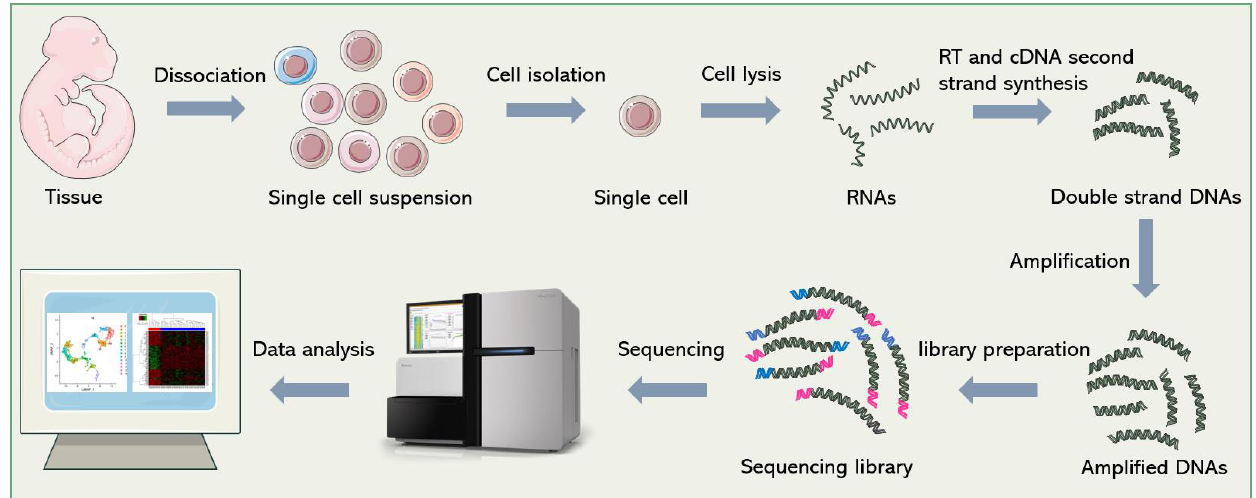
Figure 1. General workflow of scRNA-seq. Firstly, single-cell suspensions are obtained from cultured cells or tissue blocks. Then, cells are isolated and lysed. The released RNAs are reverse-transcribed into cDNAs. After second-strand synthesis and amplification, sequencing adapters are added to both ends of the cDNAs to construct the final sequencing library. Finally, bioinformatics pipelines are used to analyze the sequencing data and re-establish gene expression signatures of single cells.